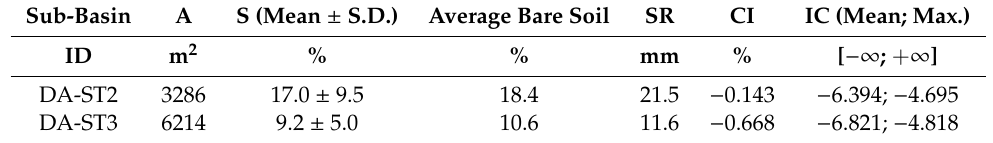
Figure 2. Picture of the sediment trap #2 ( A ) and ephemeral gully located in the drainage area of ST3 within VY3 ( B ). Table 1. Physiographic characteristics of the upslope drainage area (DA) of the two sediment traps (STs).